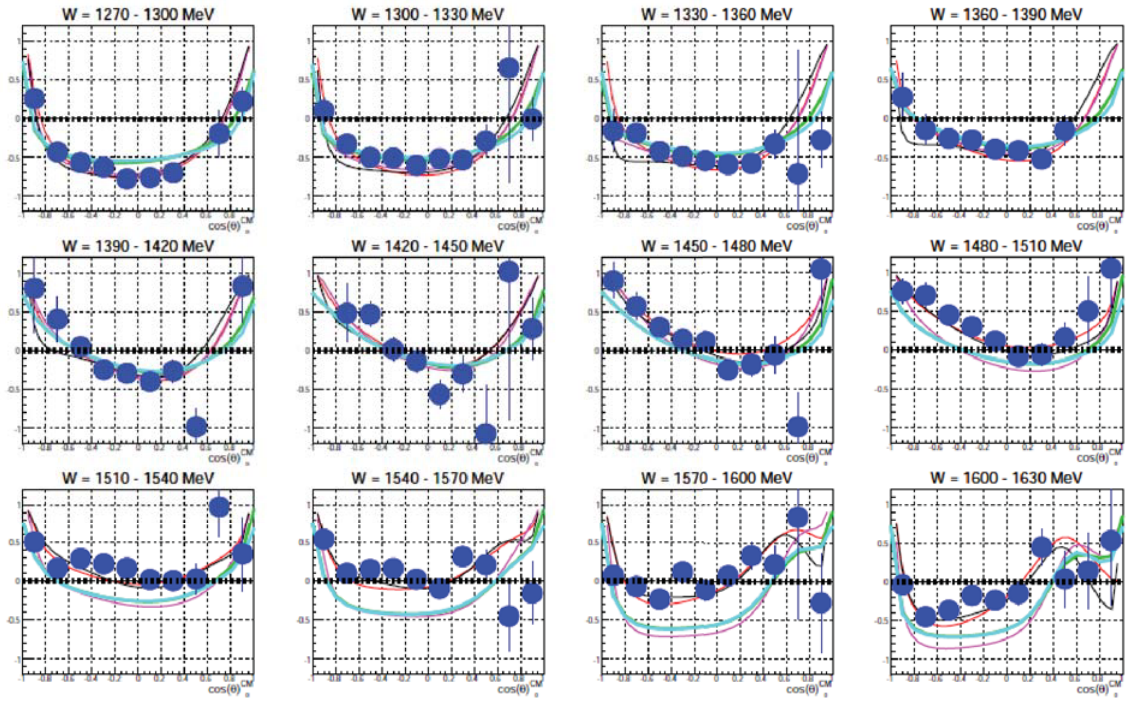
Figure 7. Results for the double polarisation observable E for the photoproduction channel γ p → π 0 p , as a function of cos θ CM selected 30 MeV energy bins, for quasi-free (blue circles) protons [20]. The results are compared to the BnGa2014-02 [21] (red line), SAID-CM12 [22] (black line), MAID [14] (magenta line), MAID + IA (cyan line), MAID + IA + FSI [15] (green line) partial wave